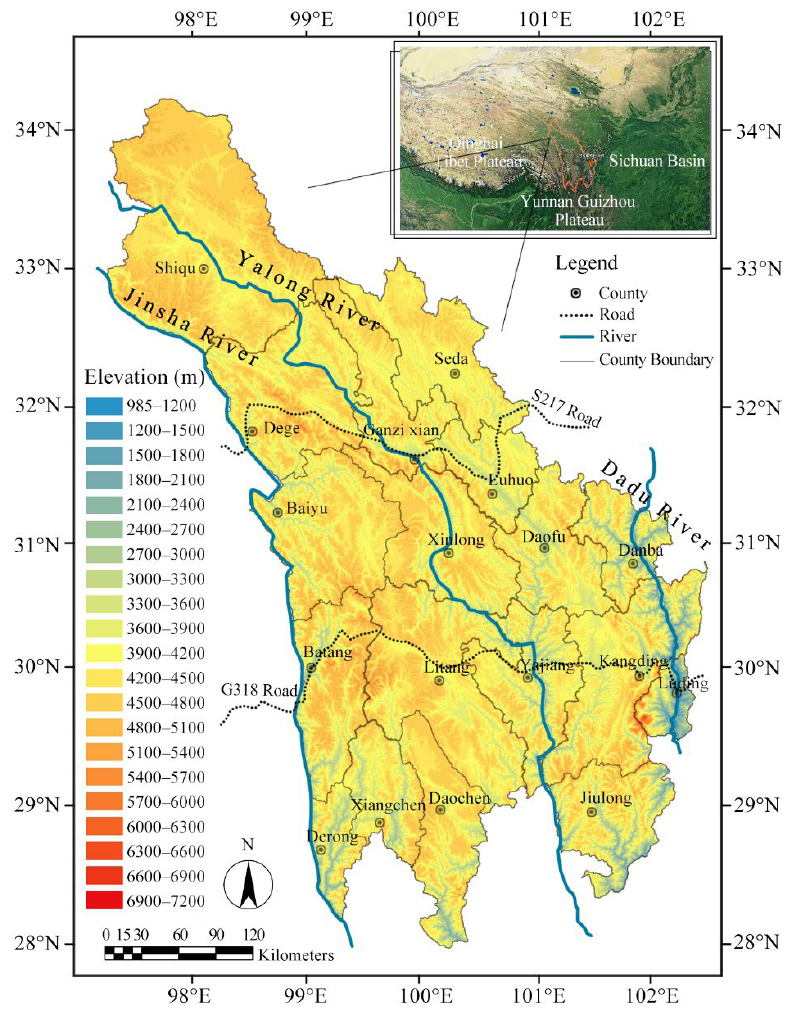
Figure 1. Location and elevation of the study area.